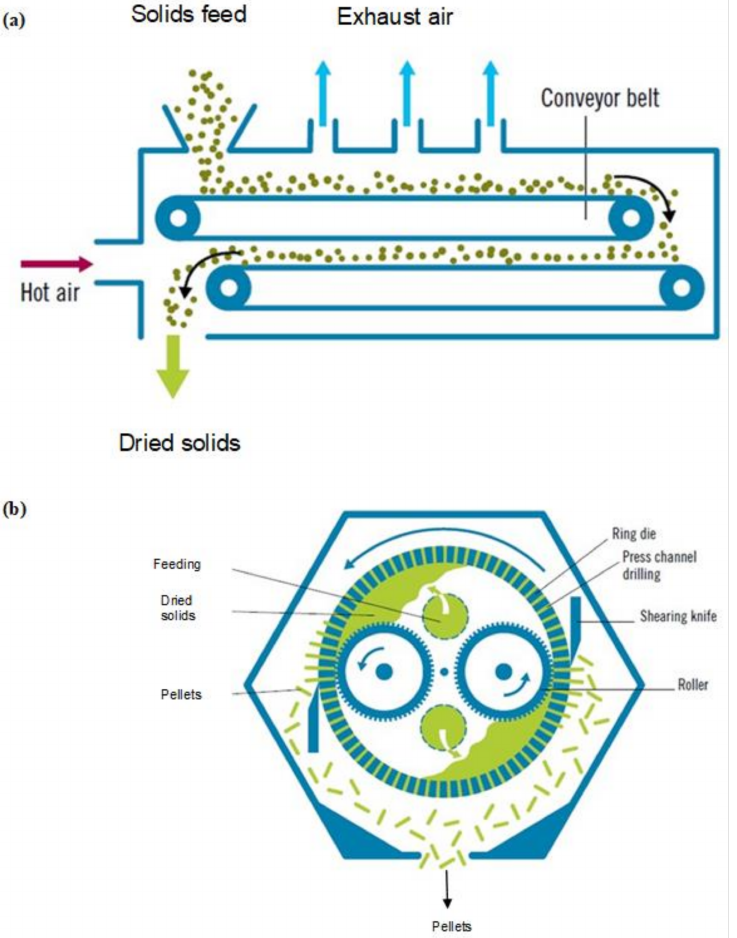
Figure 5. Diagrammatic representation of ( a ) a belt dryer and ( b ) pelletisation for processing sepa- rated manure or digestate solids (reproduced by permission from Wilken et al. 2018